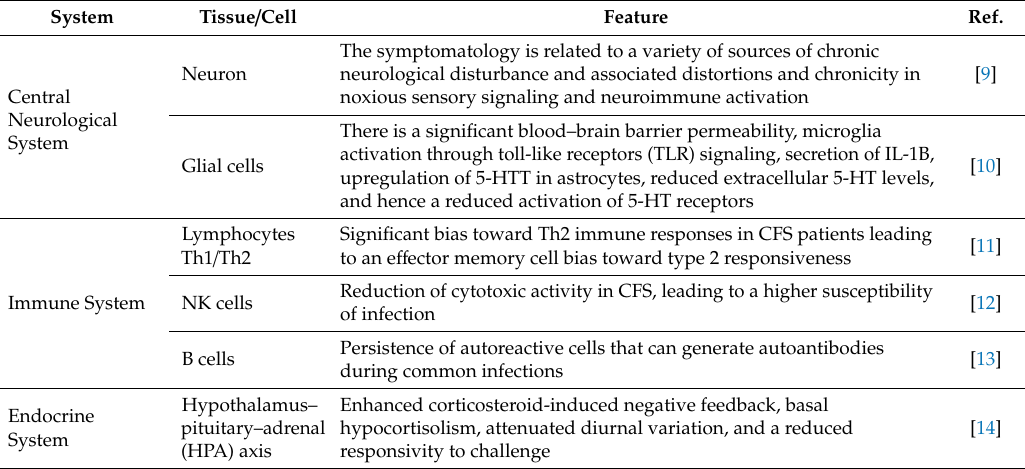
Table 1. Features and function of main tissues representing the three pillars of myalgic encephalomyelitis / chronic fatigue syndrome (ME / CFS). HPA: